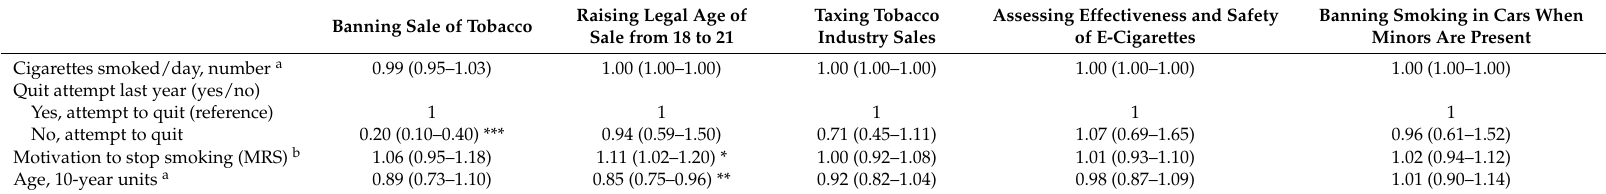
Table 4. Multivariate associations with support (agree/totally agree) for the policy statements in the sample of current smokers ( n =